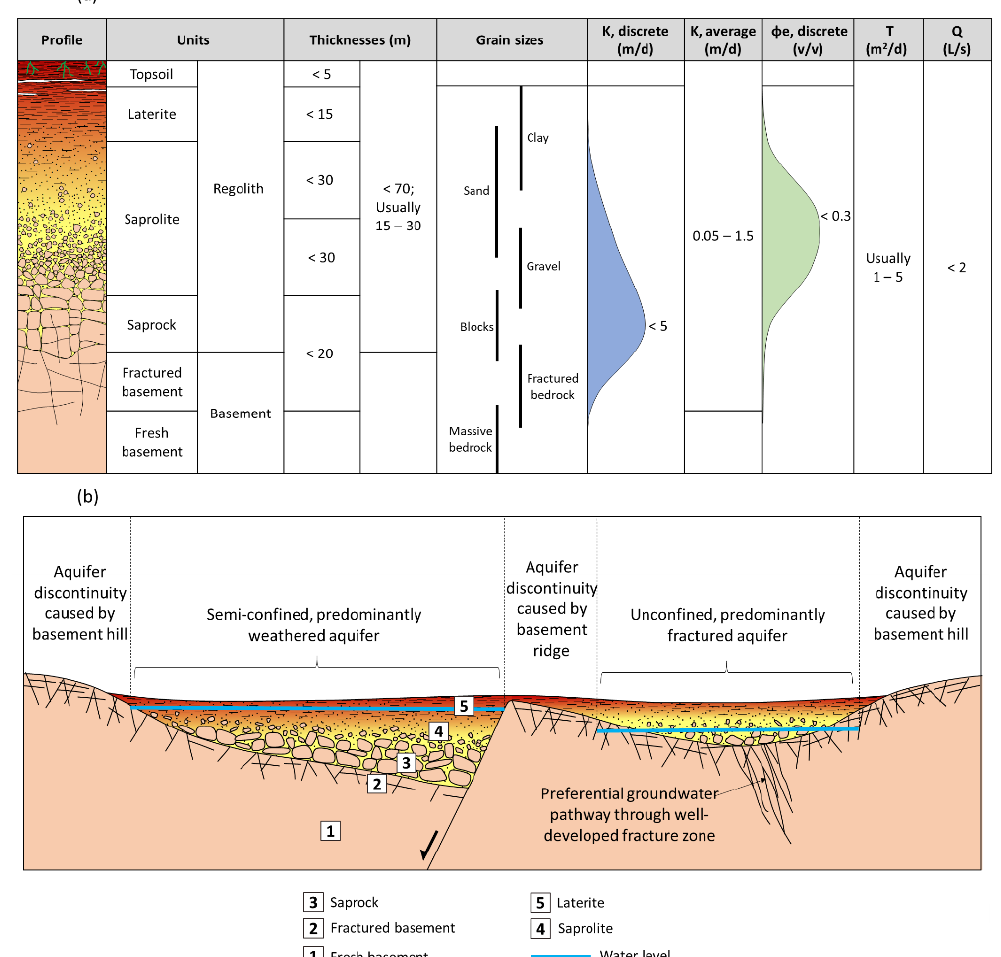
Figure 3. ( a ) Typical vertical profile of fractured/weathered basement aquifers in tropical environments. ( b ) Examples of aquifer subtypes among fractured/weathered basement aquifers in tropical